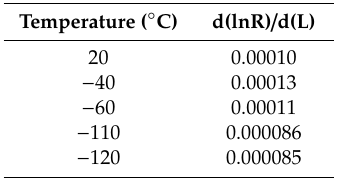
Table 2. Different slopes at different temperatures in the heatsink. Table 2. Di ff erent slopes at di ff erent temperatures in the